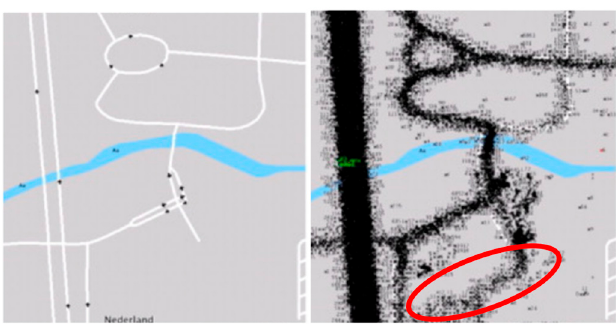
Figure 1. Detection of a missing road on the map using the trajectories of users.